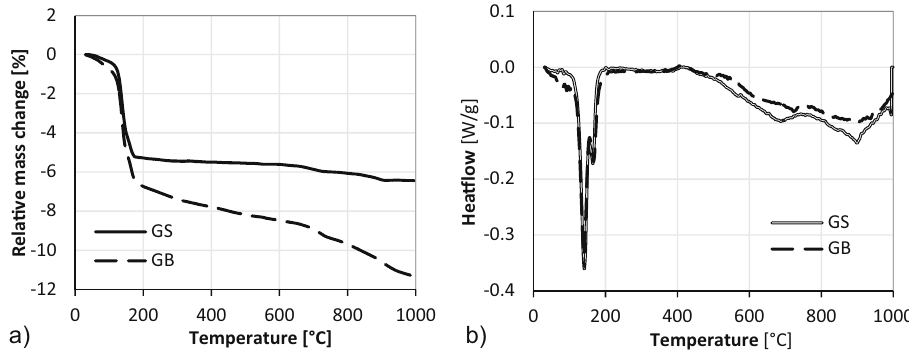
Figure 6: Thermal analysis of composites: ( a ) TG and ( b )